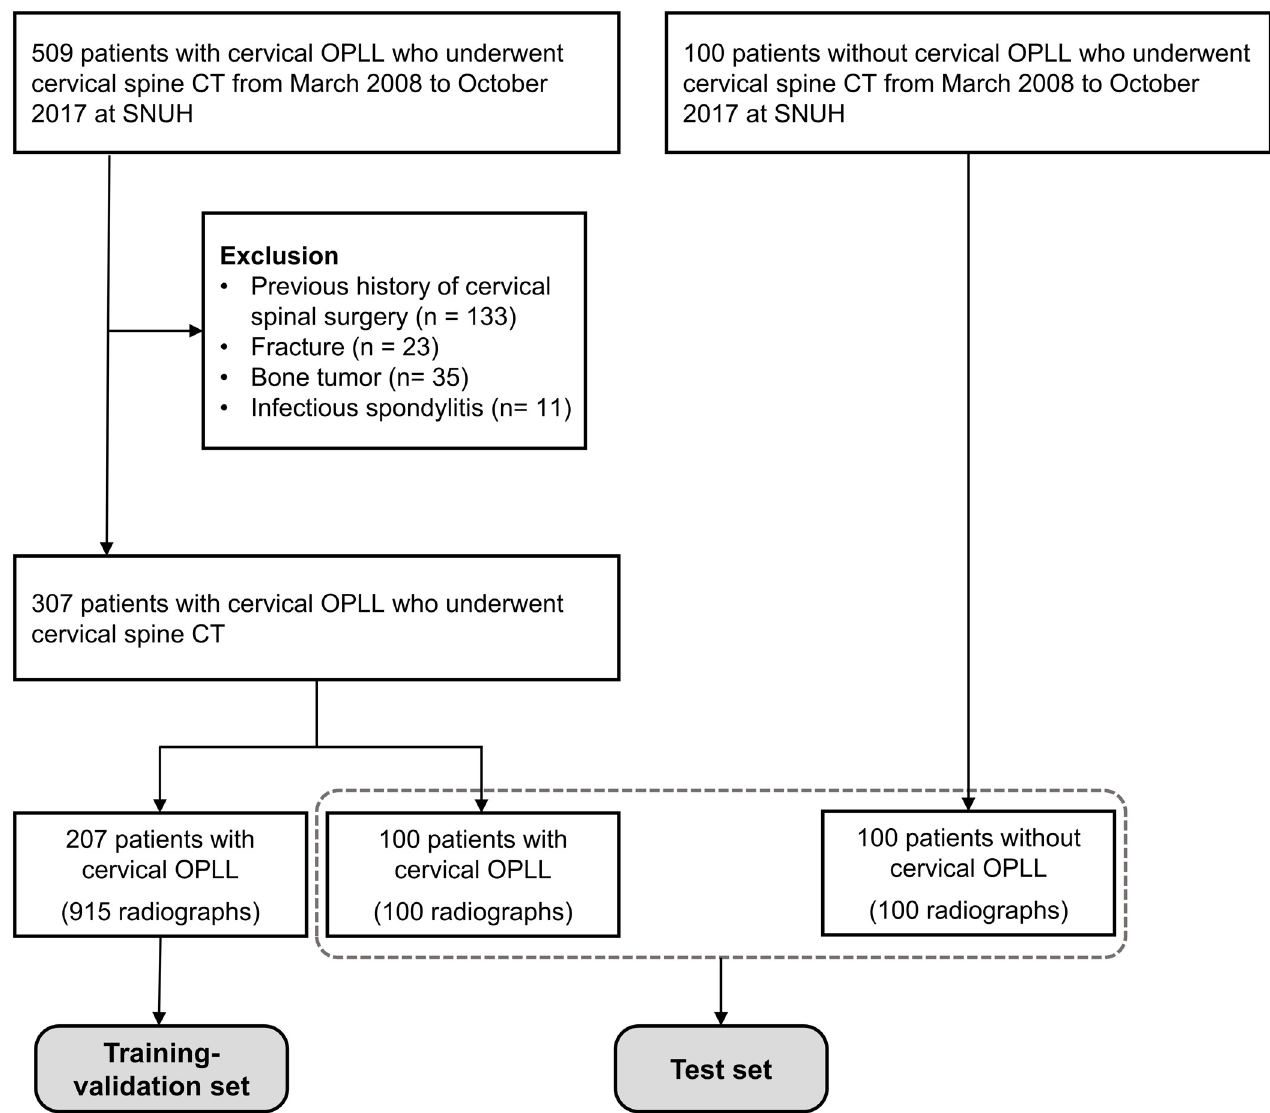
Fig 1. Flow diagram of data inclusion and